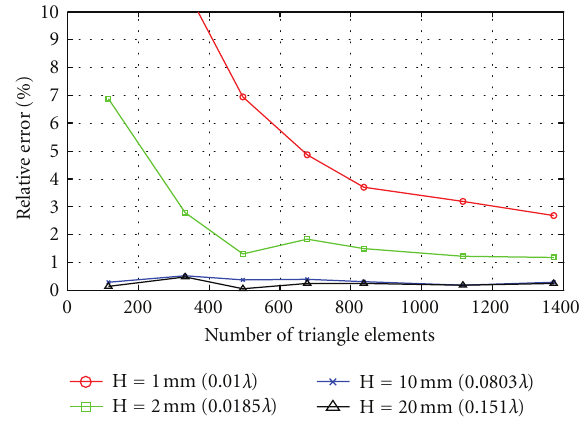
Figure 7: Relative error of the Q factor as a function of triangular elements (mesh density).